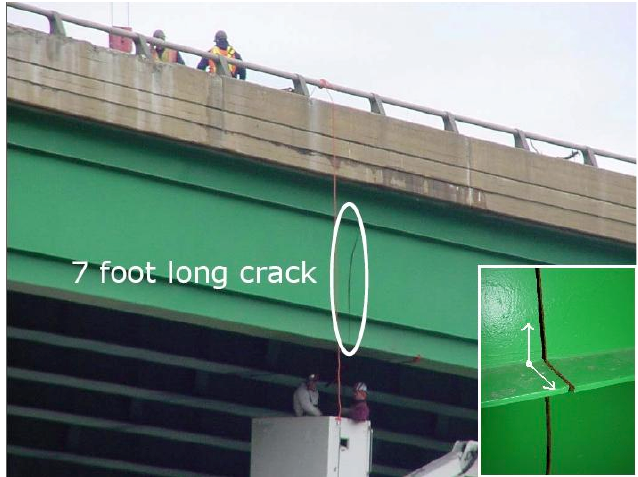
Figure 2. Fatigue cracking in a bridge girder starting from weld defects at a weld intersection point (after